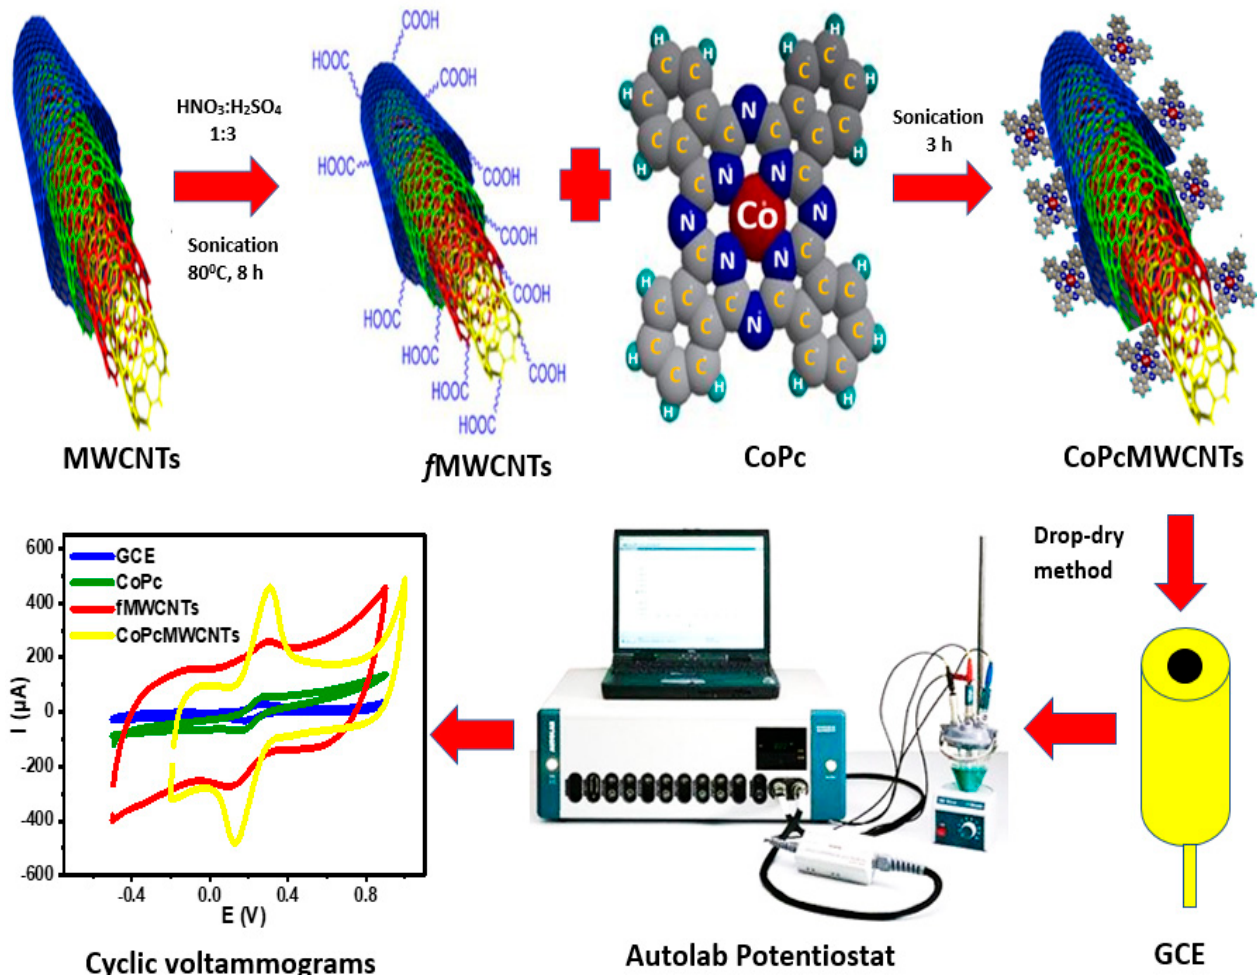
Figure 2. Fabrication and modification process of CoPcMWCNTs nanocomposite. Aragao and his research group [60] developed an electrochemical sensor for diethylstilbestrol (DES) detection by modifying GCE with gold (Au) nanoparticles and CoPcMWCNTs nanocomposites via electrodeposition. Prior to this, the synthesis of the nanocomposites was achieved through an ultrasonication method. The mechanism of the oxidation of DES molecules on the CoPcMWCNTs/AuNPTs/GCE (which was mainly an adsorption-controlled process) involves two-step processes with one electron each. The first step is the oxidation of neutral DES molecule to phenoxy ion, while the second step is the formation of phenoxonium anion. The developed CoPc-fMWCNTs/Au/GCE catalyzed diethylstilbestrol’s electrochemical oxidation and enhanced its sensitivity compared with the unmodified electrode. Through the SWV technique, DES was determined in Britton– Robinson (BR) buffer solution (pH 10) with an LOD of 0.199 µ M and quantification limits of 0.664 µ M. An interference study showed that most ions and molecules (K + , Na + , Ca 2+